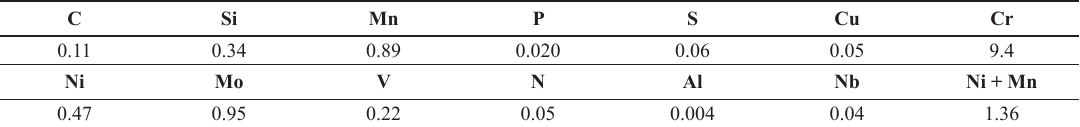
Table 4. Chemical composition of flux cored electrode E91T1-B9 (%